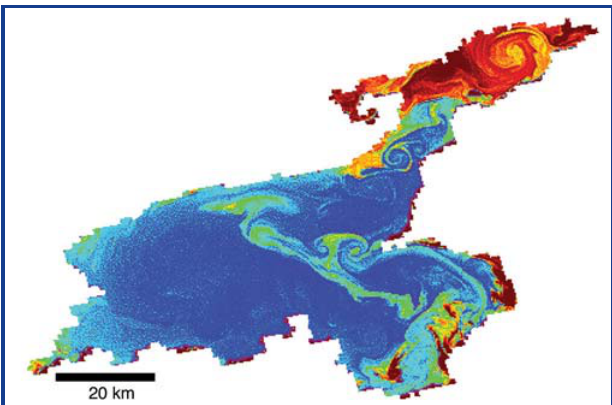
Figure 6. S atellite image (550 nm at-sensor radiance) of Lake Van taken on 20 S eptember 2006. Note the wind-driven surface eddies redistributing suspended surface-water particles mostly consisting of authigenic carbonate (“whitings”). Figure 7. The new large Deep Lake Drilling S ystem (DLD S ) operated by DO S ECC with the new top-head-drive rotary